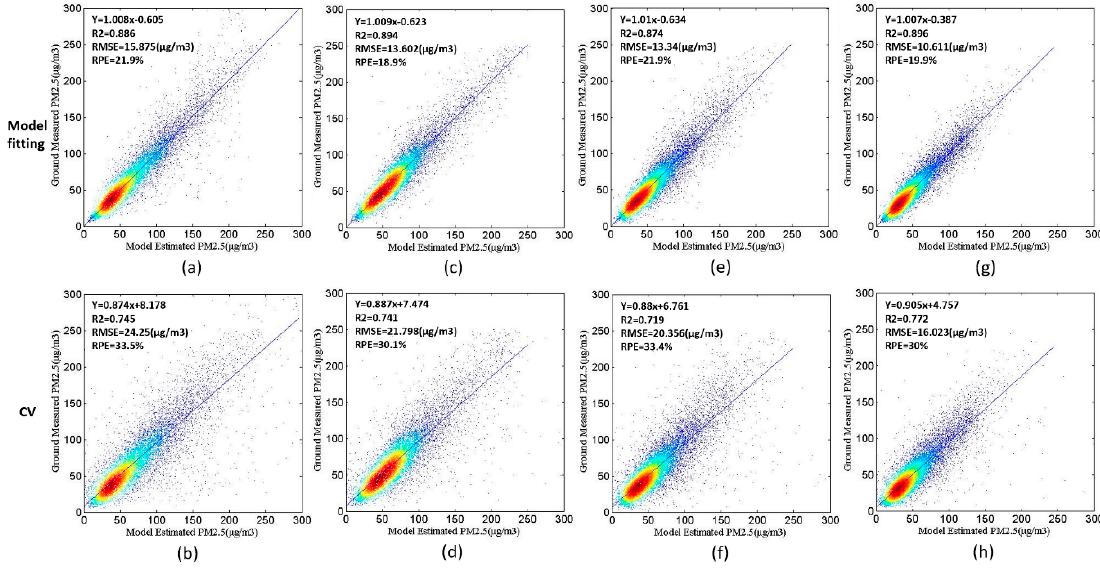
Figure 4. The accuracy evaluation of predicted PM 2.5 in group (i) from the first-stage GAM model. (a) and (b): 2013; (c) and (d): 2014; (e) and (f): 2015; (g) and (h): 2016. The red lines are regression lines.